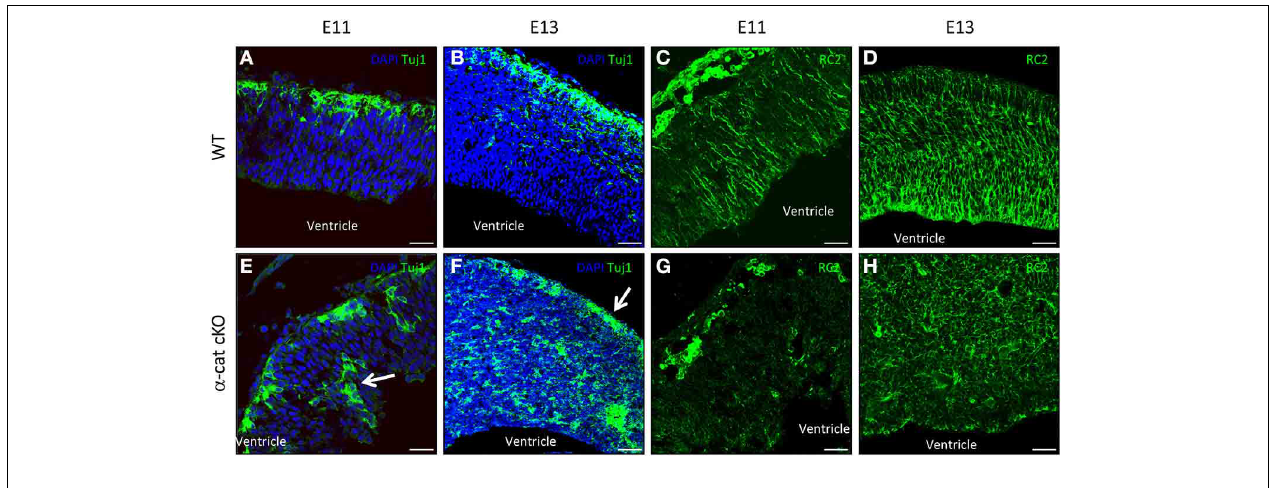
FIGURE 5 | Neuronal position and stem cell morphology upon loss of α -catenin. Fluorescence micrographs of coronal cortical sections of E11 and E13 WT (A–D) and α -cat cKO (E–H)